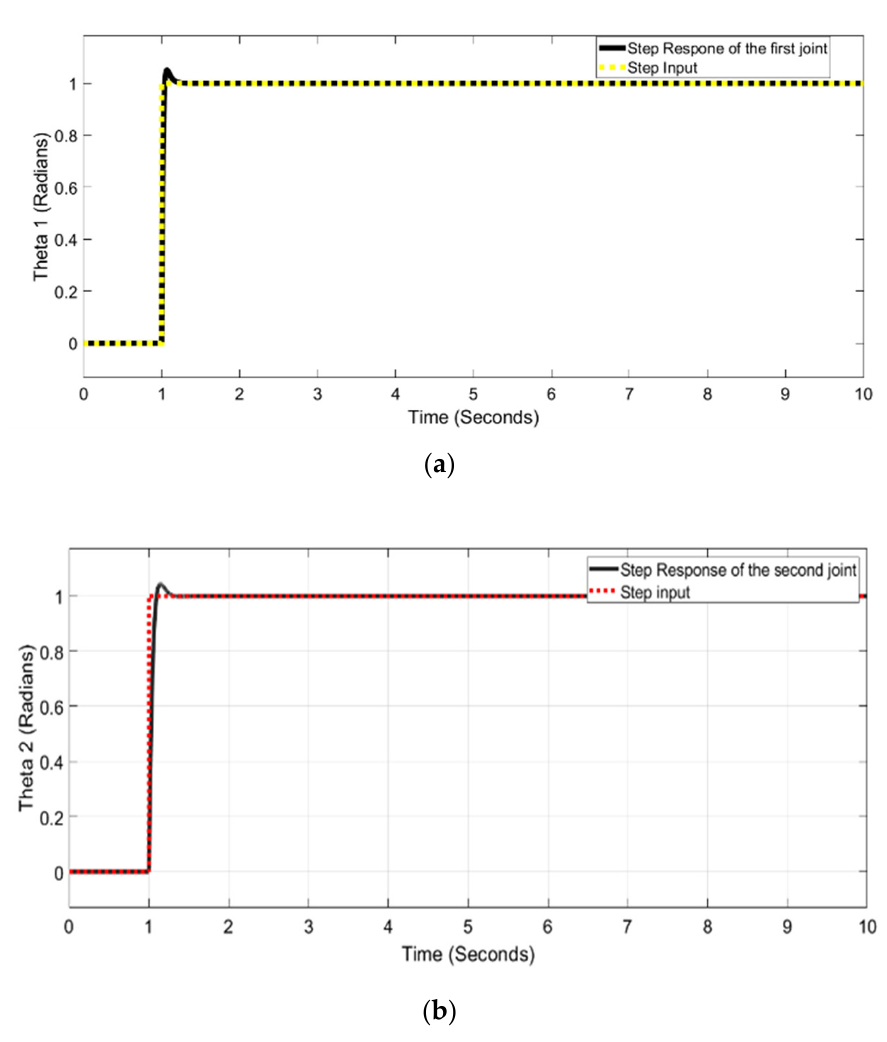
Figure 18. ( a ) Real-time step response of shoulder abduction/adduction rotation ( θ 1 ). ( b ) Real-time step response of shoulder flexion/extension rotation ( θ 2